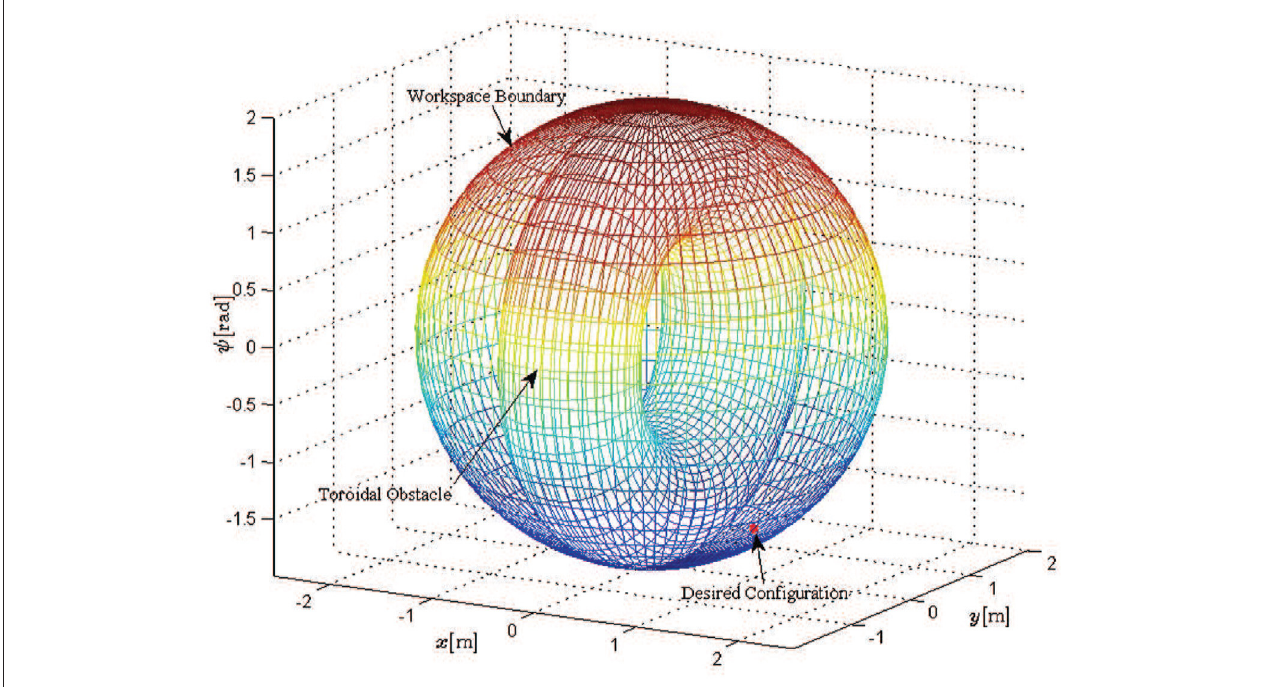
FIGURE 10 | The feasible workspace for oriented planar motion of a long formation.